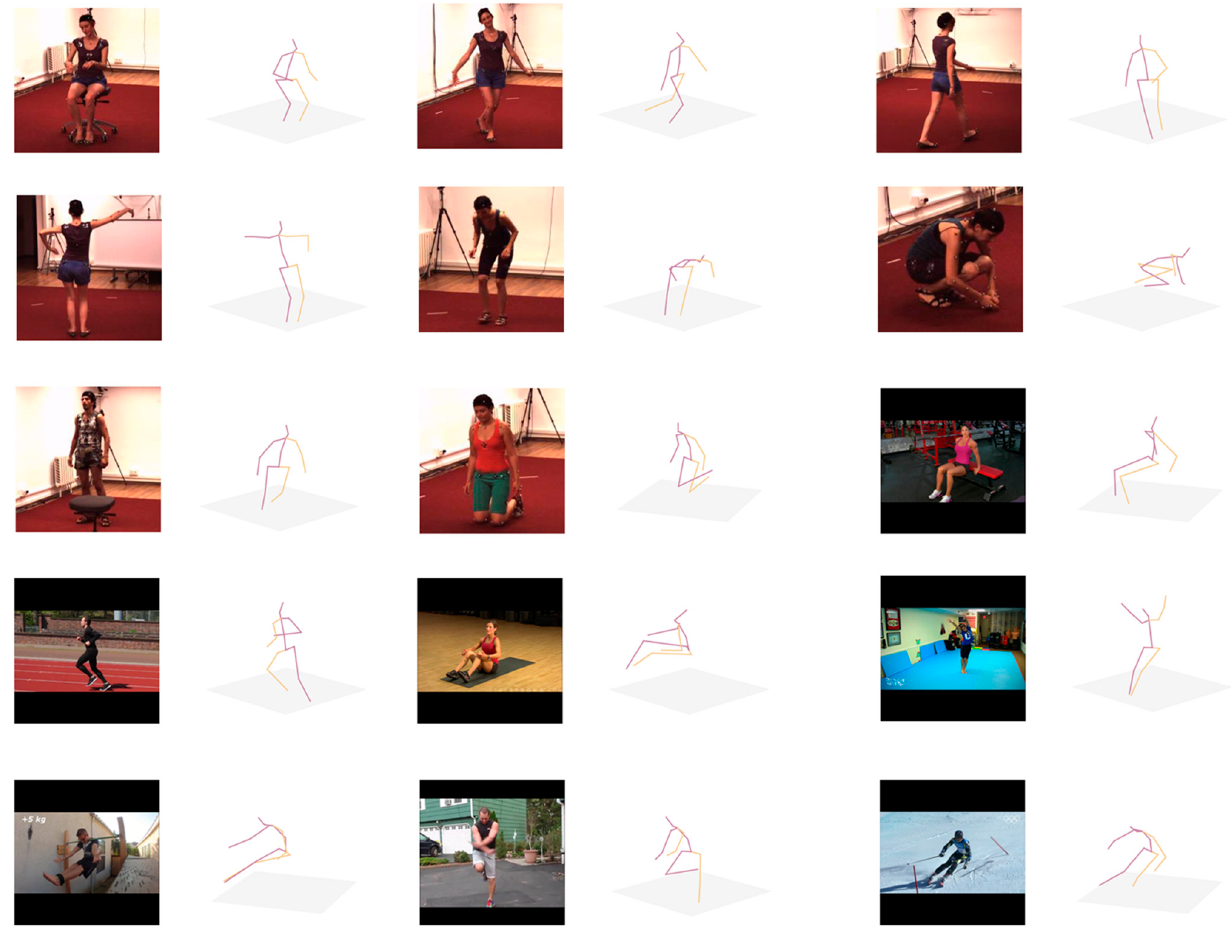
Figure 4. Qualitative results of 3D human pose on Human3.6M dataset. Predicted poses are rotated and zoomed for the consistency of perspective with original image.